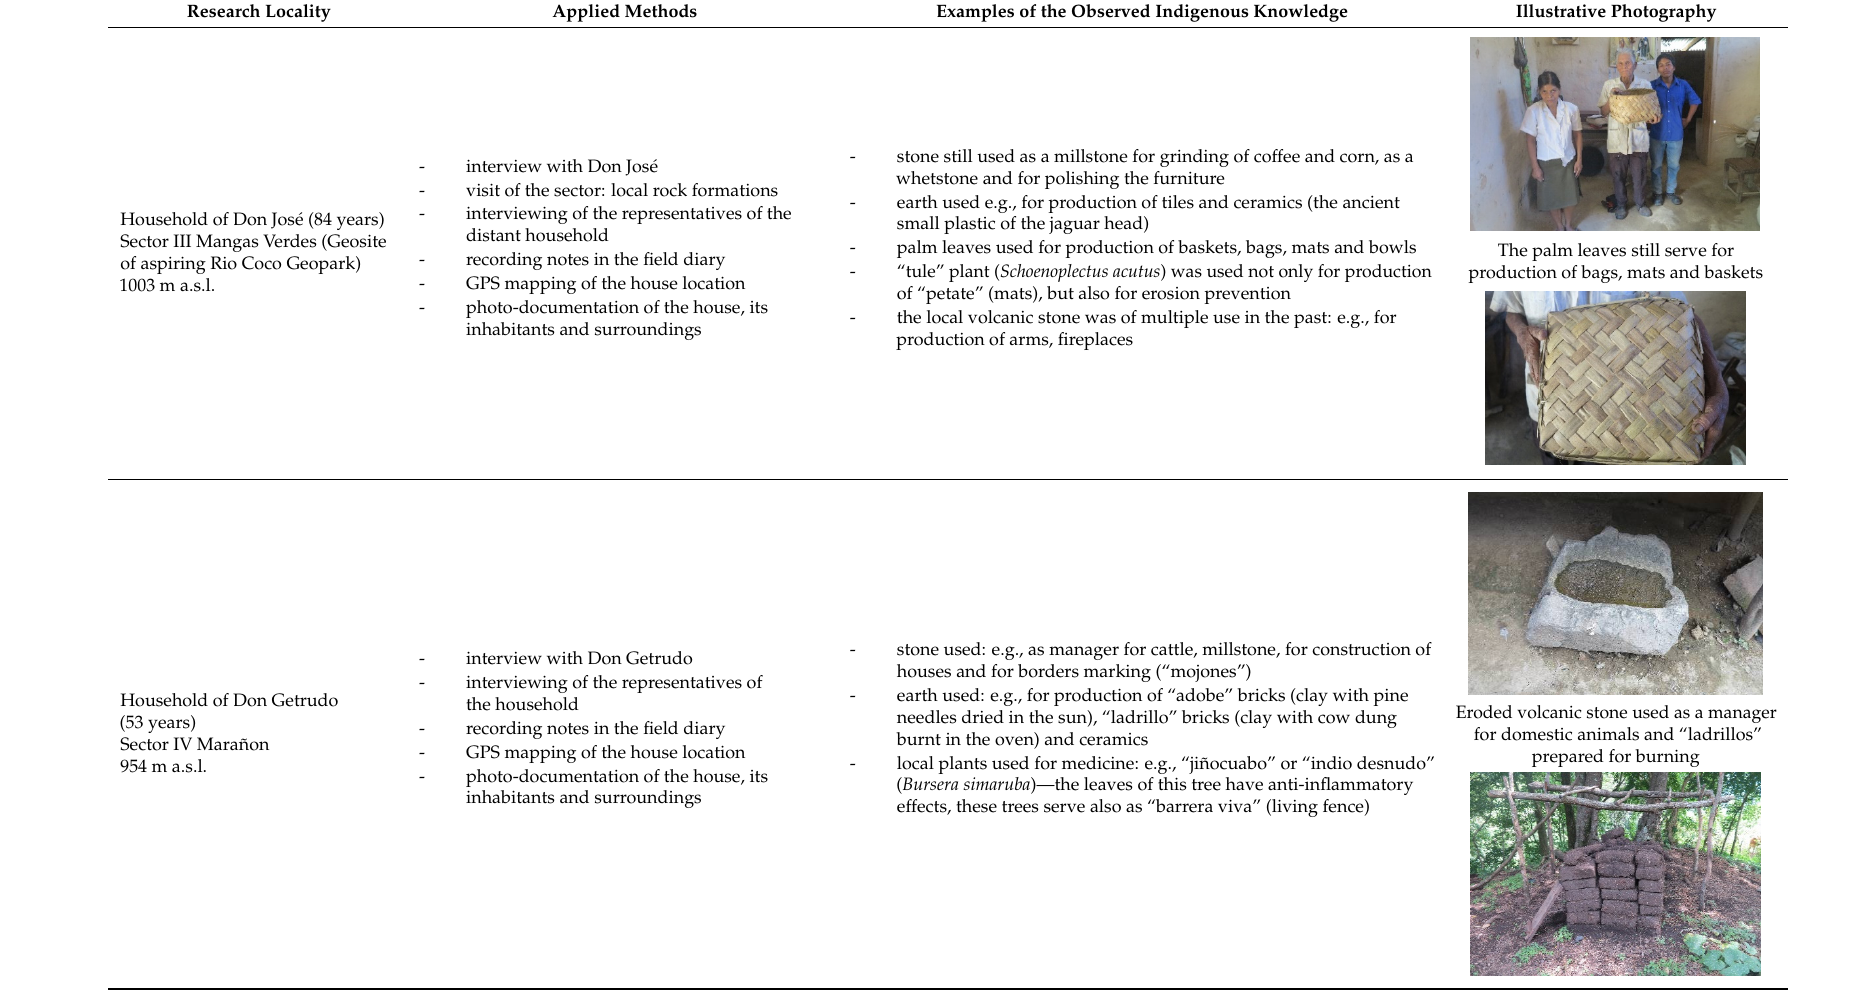
interviewing of the representatives of the household